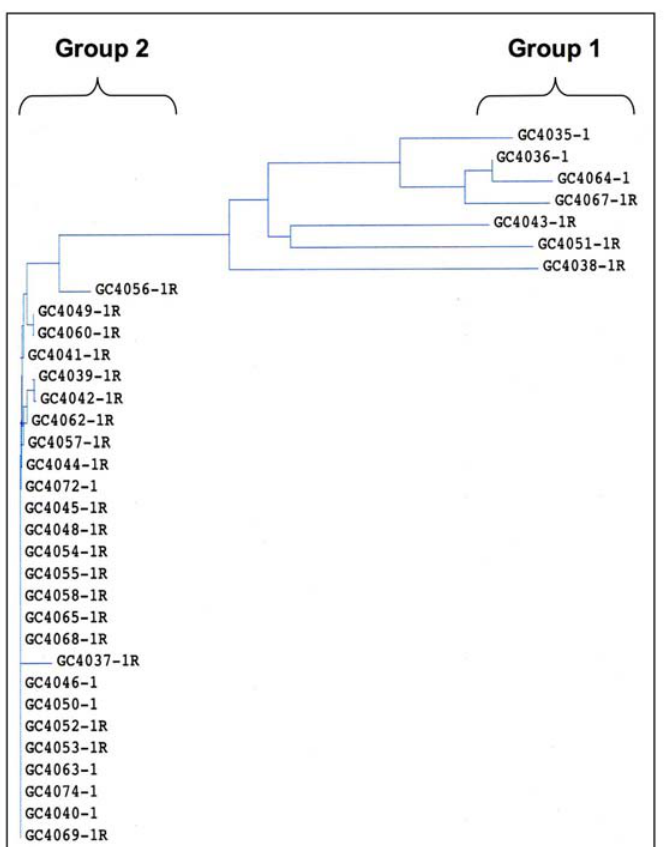
Figure 9 . Schematic representation of aptamers selected using the primer-free random DNA library protocol. Selection was performed for 10 rounds, and selected aptamers were cloned and sequenced. Analysis of the sequences showed that they fell into 2 distinct groups. Binding experiments with radioactivity-labeled consensus sequences showed that binding of the 2 consensus sequence groups was additive, indicating that they targeted distinct sites. Binding parameters are currently being characterized and will be reported